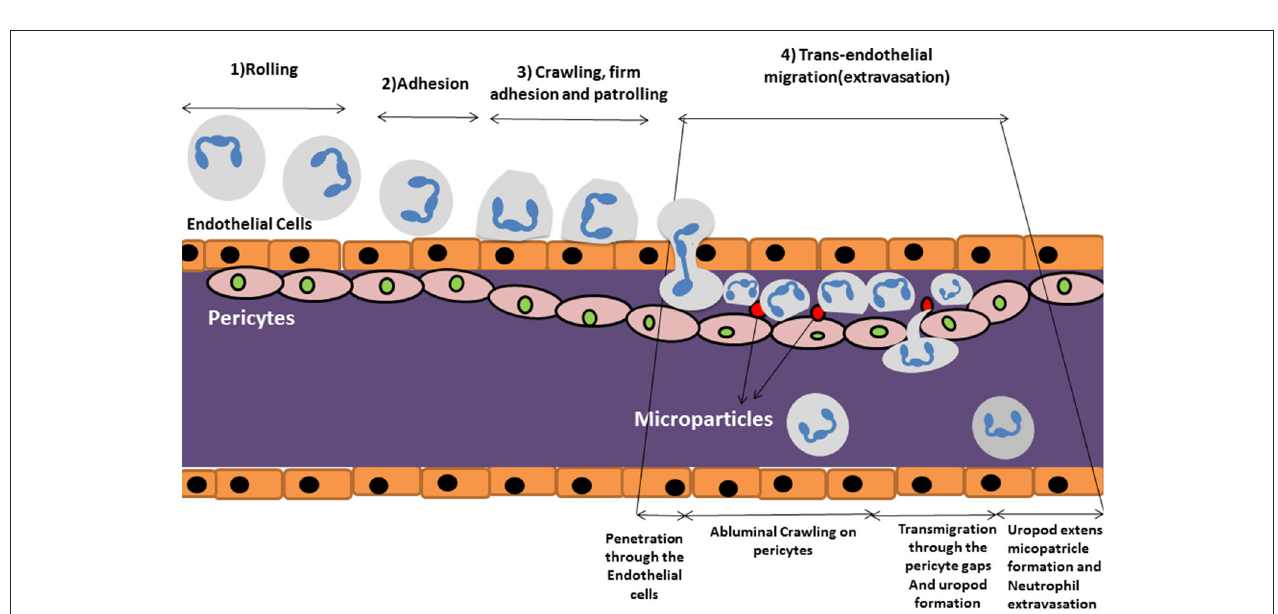
FIGURE 2 | Schematic review of neutrophil extravasation cascade. The process of neutrophil migration begins with neutrophil “tethering to” the endothelium of blood vessels in steps (1) rolling, (2) adhesion, and (3) crawling, firm adhesion and patrolling. (4) Trans endothelial migration occurs after approaching the site of inflammation where they cross the blood vessel wall in an extravasation step in which neutrophils travel along the endothelial basement membrane until finding a small gap between pericytes. They start migrating through the space by forming a protruding uropod which allows neutrophils to access to the inflamed area. Microparticle formation occurs following uropod formation which is shown to have pivotal role in controlling vascular